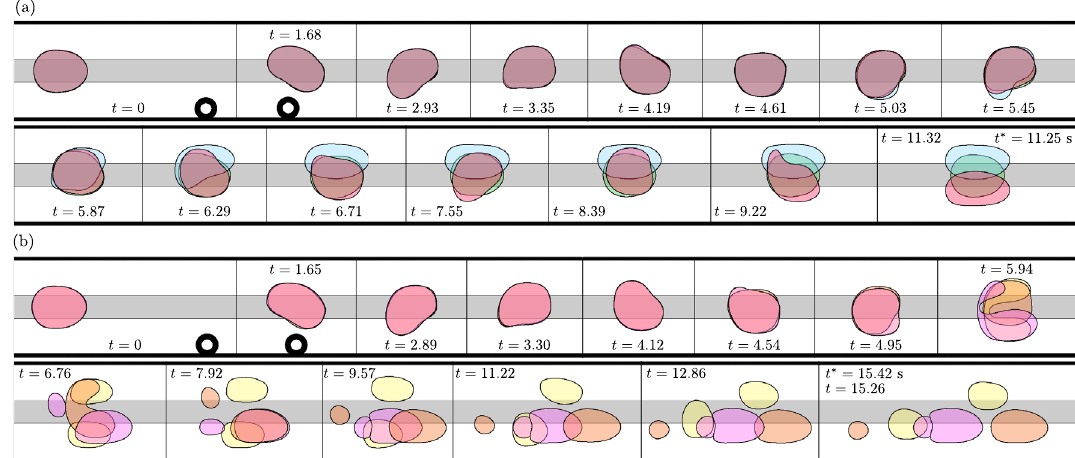
Figure 2. ( a , b ) Superimposed experimental time-sequences of bubble evolutions following their circumvention of an obstacle, which constricts the channel width by 21.7% . In each case, the dimensionless flow rate is Q = 0.018 . The bubble centroids are aligned in the streamwise direction. The time-sequences in ( a ) are examples of direct evolutions towards each of the three stable states available to the initial bubble, whereas the time- sequences in ( b ) are examples of evolutions that feature bubble mation of a bubble. Bubble evolutions were filmed in top-view by a steadily translating camera and, in this paper, they are represented by a series of instantaneous snapshots of the bubble contour. Time-labels are given in terms of a dimensionless time t . A comprehensive description of the experimental setup and protocols used to reproducibly generate and propagate bubbles of prescribed size, alongside details pertaining to the nondimen- sionalisation process, are provided in “Materials and methods”. We begin with the experimental observations following the perturbation of a bubble through the use of a modestly-sized obstacle that constricted the channel width by 21.7% . Within a small interval of the dimension- less driving flow rate ( 0.018 < Q < 0.019 ), visibly-indistinguishable bubbles were observed to evolve towards multiple distinct long-term outcomes at the same experimental parameters following their circumvention of the obstacle. A set of three experimental time-sequences are superimposed in Fig. 2a where, in each case, a bubble is 0.018 . The bubbles deform significantly as they circumvent the obstacle propagated towards the obstacle at Q = 1.68 . Each bubble begins to oscillate transiently as it propagates away from the obstacle. At early times at t = 2.93 and t 3.35 , the bubbles remain indistinguishable. However, small- during their oscillation, e.g. at t = = 4.19 , which grow significantly scale deviations in the shapes of their interfaces become visibly apparent by t = by t